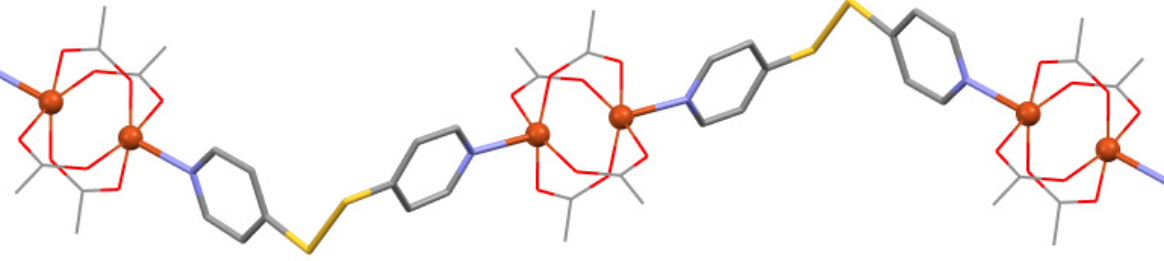
(CH COO) ( μ - dtdp )] 2 3 4 n